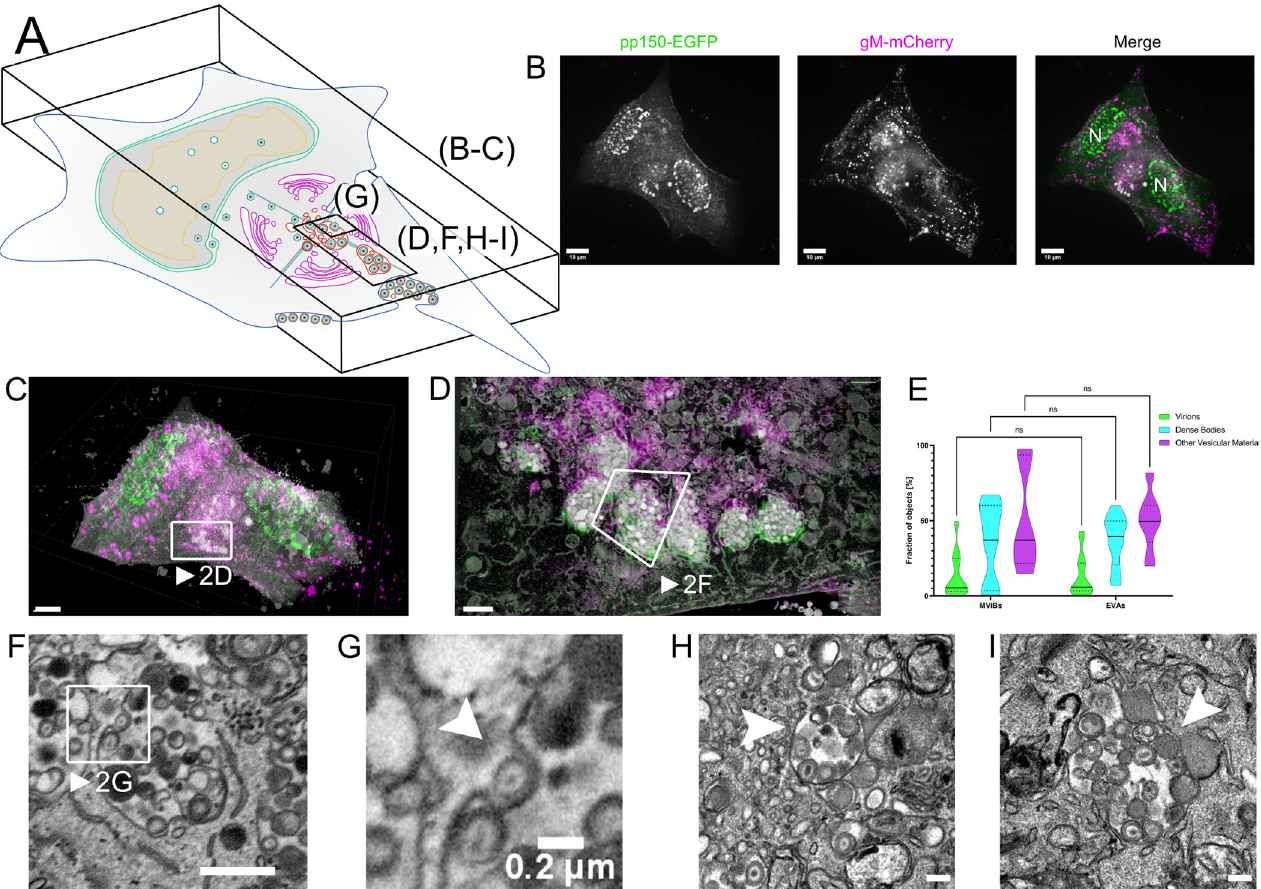
Fig 2. Correlative fluorescence and EM detect MViBs filled with virus progeny. 2A Overview indicates the subfigures’ positions in relation to the whole cell. CLEM of HFF-cells infected with HCMV-pp150-EGFP-gM-mCherry (MOI = 3) at 4 dpi. 2B Maximum z-projection of a 3D spinning-disk confocal microscopy stack. pp150-EGFP is colored in green and gM-mCherry signals in magenta. N marks nuclei. Scale bar indicates 10 μ m. 2C Correlative overlay of the fluorescence data shown in 2B and corresponding SBF-SEM data. Scale bar indicates 7 μ m. The white frame marks MViBs. See also Supplementary Video 3B in https://doi.org/10.5281/zenodo.6611135. 2D Correlative rendering of MViBs highlighted in 2C. The white frame marks one MViB detailed in 2F 2E Quantitative comparison of MViB and EVA contents. Statistical analysis was performed with a 2-way ANOVA and Sˇı´da´k’s multiple comparisons test. Viral products and other vesicular material was found in similar ratios in both structures. No significant differences in the contents of MViBs and EVAs could be found. 2F Section from the rendered SBF-SEM stack shown in 2D. Image signals were inverted to facilitate comparison with TEM images. An HCMV capsid potentially budding into an MViB is highlighted (white arrow). Although caution is indicated while interpreting the directionality of a process in static images from electron microscopy. Also, refer to Supplementary Videos 3A and 3B in https://doi.org/10.5281/zenodo.6611135 for a 3D rendering of the presented data. Scale bar indicates 1 μ m. 2G Insert from 2G. Arrow marks viral capsid seemingly arrested in a potential budding process. Scale bar indicates 0.2 μ m. 2H-I HFF cells were infected with HCMV-TB40-WT at an MOI of 5, fixed, and processed for EM as described for SBF-SEM at 120 hpi with the modification that the cells were embedded for classical sectioning in Epon without conductive fillers. Filled arrowheads indicate MViBs filled with virus progeny. All scale bars represent 0.2 μ m.